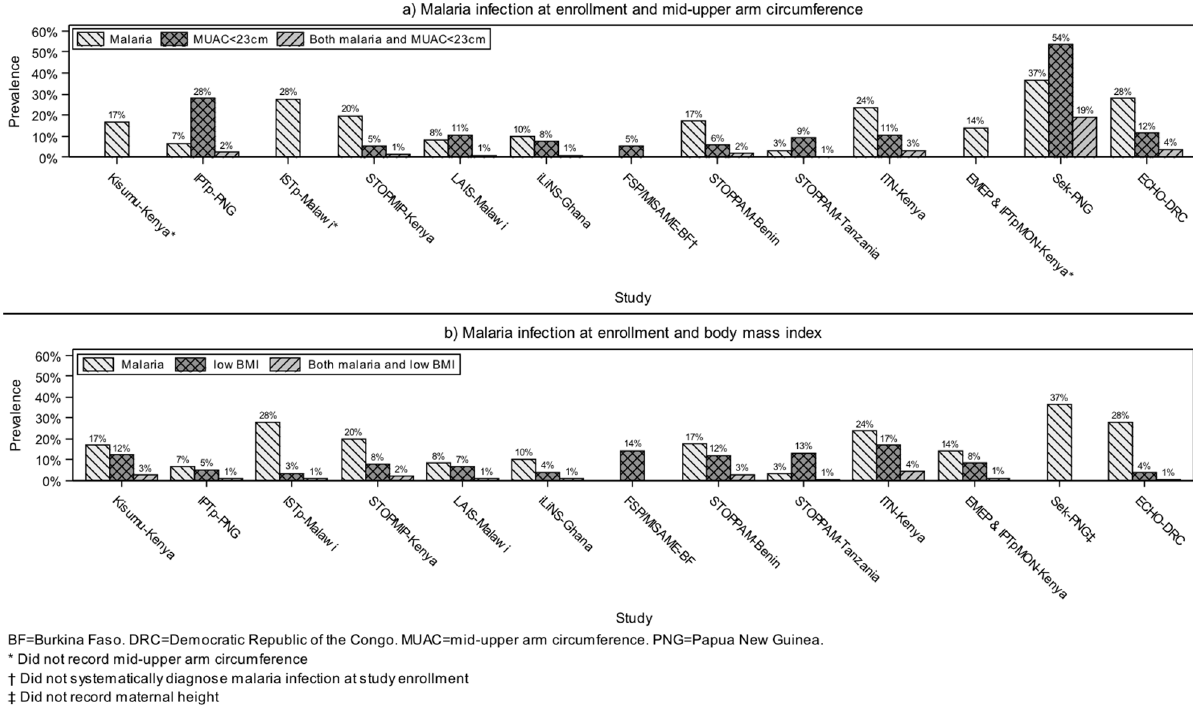
Fig 2. Prevalence of malaria infection at enrollment, malnutrition (mid-upper arm circumference [MUAC] < 23 cm or body mass index [BMI] < 18.5 kg/m 2 ), and joint malaria infection and malnutrition among 14,633 live birth pregnancies from women participating in studies (years1996–2015)included in the Maternal Malaria and Malnutrition (M3)